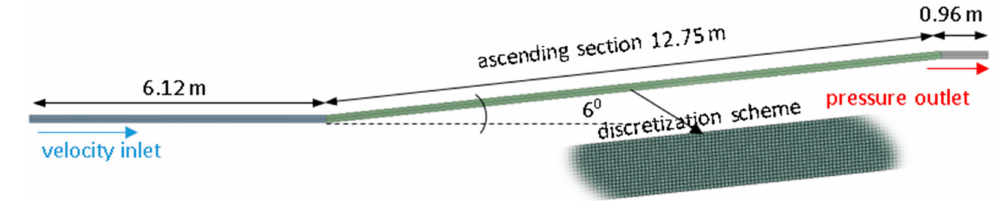
Figure 5. Geometry and method of discretization of the 2D model of the 19.83 m long installation section containing the